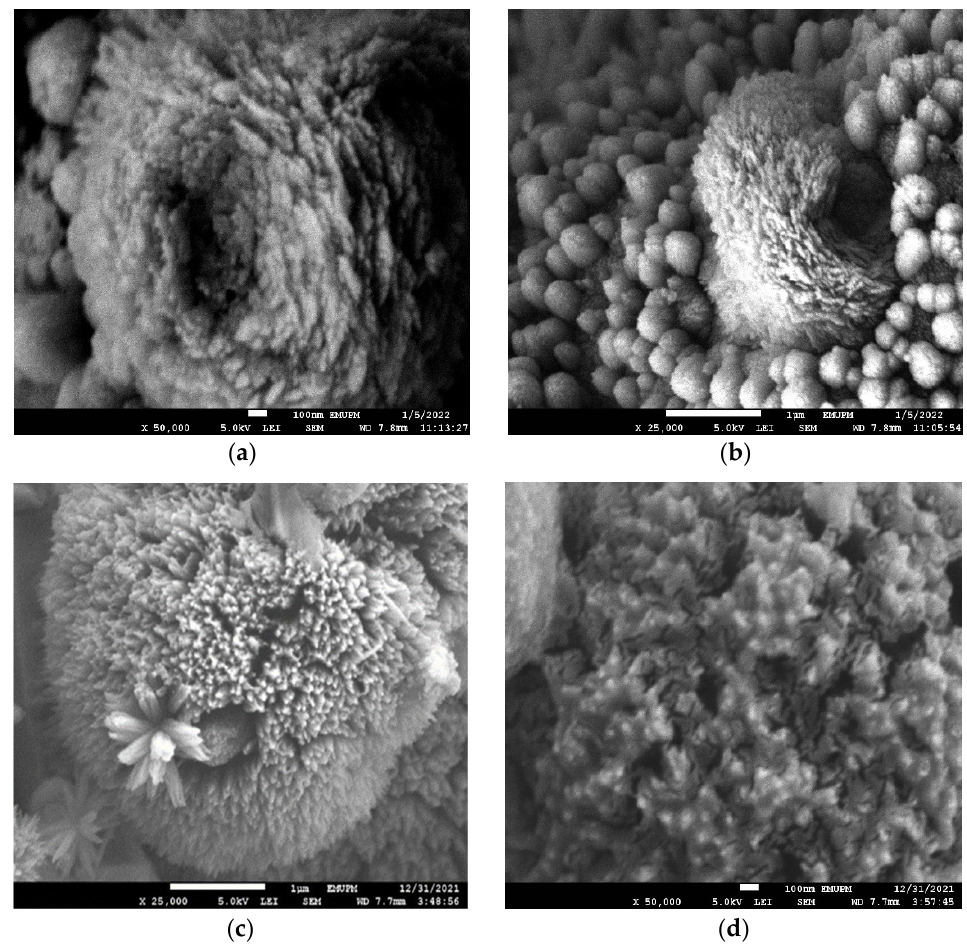
Figure 7. FESEM images of ( a , b ) nCPs (0g DEX) and ( c , d ) nCPs (2g DEX).